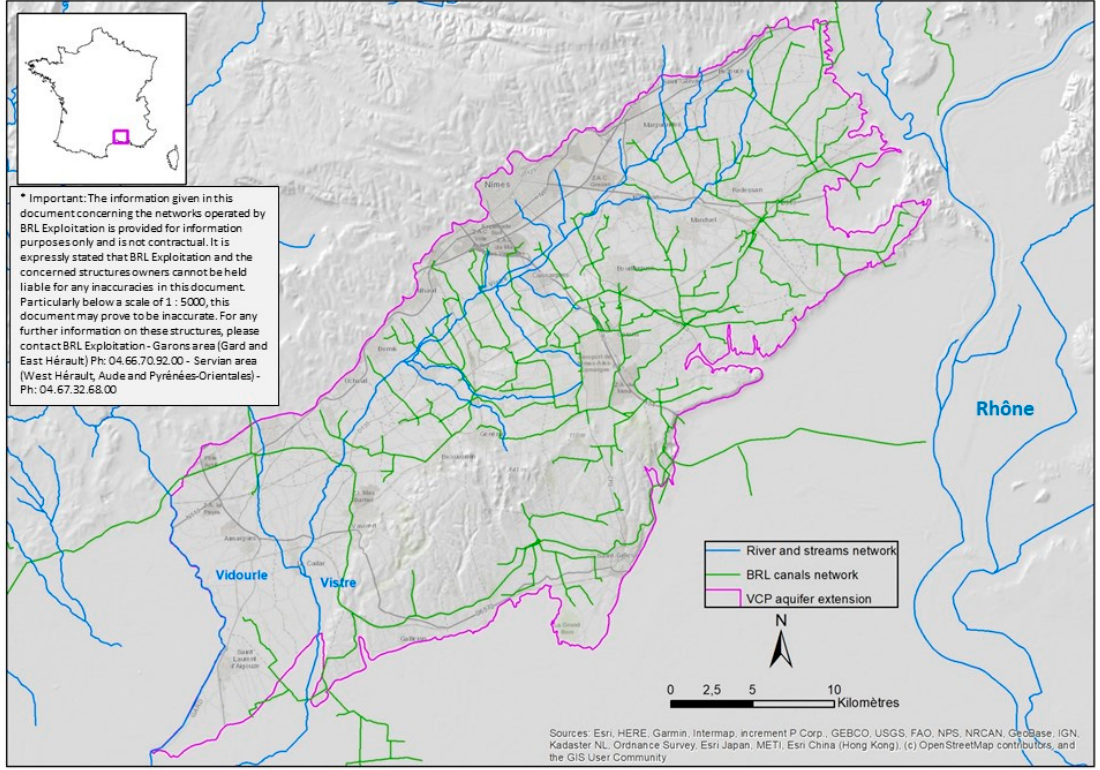
Figure 3. Map of the Vistrenque and Costières Plain (VCP) case study. Available surface water for MAR purposes is identified (in blue: rivers and streams; in green: Bas-Rhône and Languedoc regional water company (BRL) canal network).